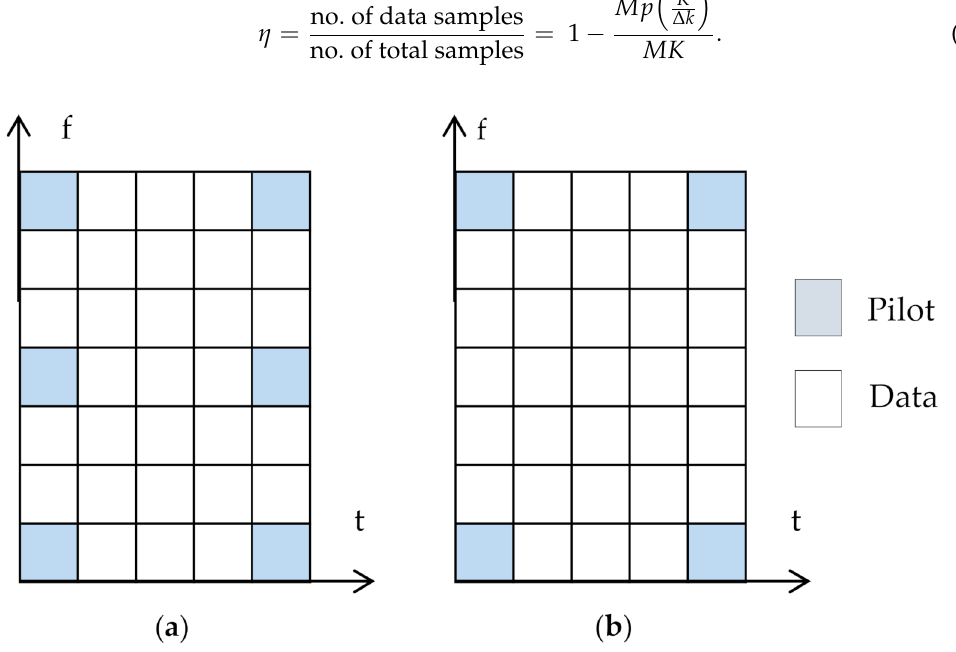
Figure 2. Pilot positions in time-frequency grid: ( a ). ∆ k = 3, Mp =2; ( b ). ∆ k = 6, Mp =